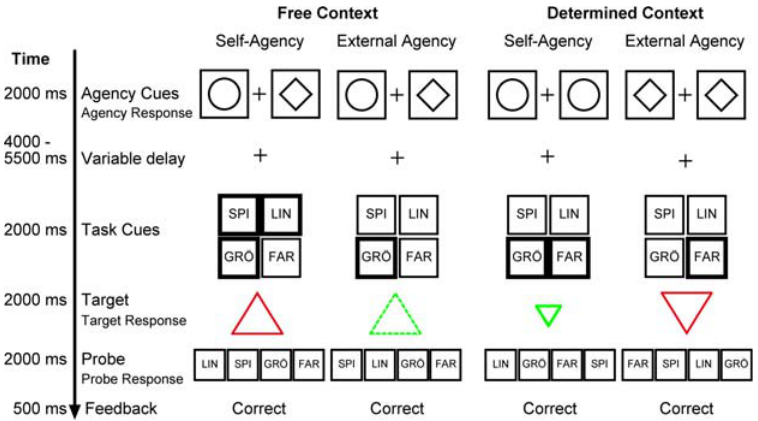
Figure 1. Paradigm. Schematic drawing of the trial sequence for free-context and determined-context trials. ‘Agency cues’ could either be circles (self-agency: participants choose the task themselves) or diamonds (external-agency: the task is chosen by the experimenter). In free-context trials, participants could choose to accept agency (by pressing the response button that was aligned to the circle cue in a spatially compatible mapping) or to decline agency (by pressing the response button aligned with the diamond cue). In determined-context trials, participants were either informed that agency was theirs (both agency cues were circles) or that agency was not theirs (both cues were diamonds). Agency cues were presented for 2000 ms and were followed by a variable interval of 4000–5500 ms. Subsequently, ‘tasks cues’ were presented in the 2 6 2 grid with German abbreviations ‘FAR’ (color), ‘SPI’ (orientation), ‘GRO¨’ (size), and ‘LIN’ (line). Quadrants with bold lines indicated that a task was available for choice (varied between 1–3 degrees of freedom). Target and probe stimulus were presented until a response was given or an interval of 2000 ms was exceeded. Finally, feedback was presented for 500 ms. doi:10.1371/journal.pone.0001899.g001 vs. external-agency) and context (free context vs. determined context) did reveal no significantly stronger activations for self- agency and free context.